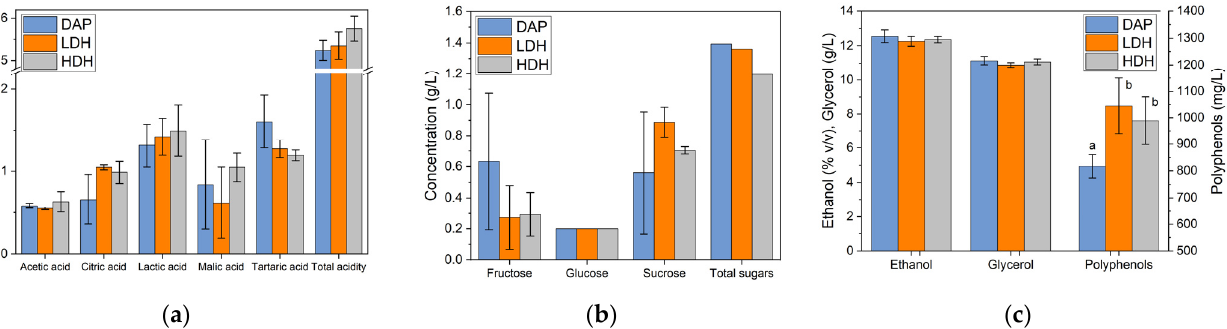
Figure 3. Characterization of Cabernet Sauvignon wines produced by supplemented fermentations with different nitrogen sources: ( a ) acids, ( b ) sugars, and ( c ) alcohols and polyphenols. Different letters indicate significant differences ( p < 0.05).